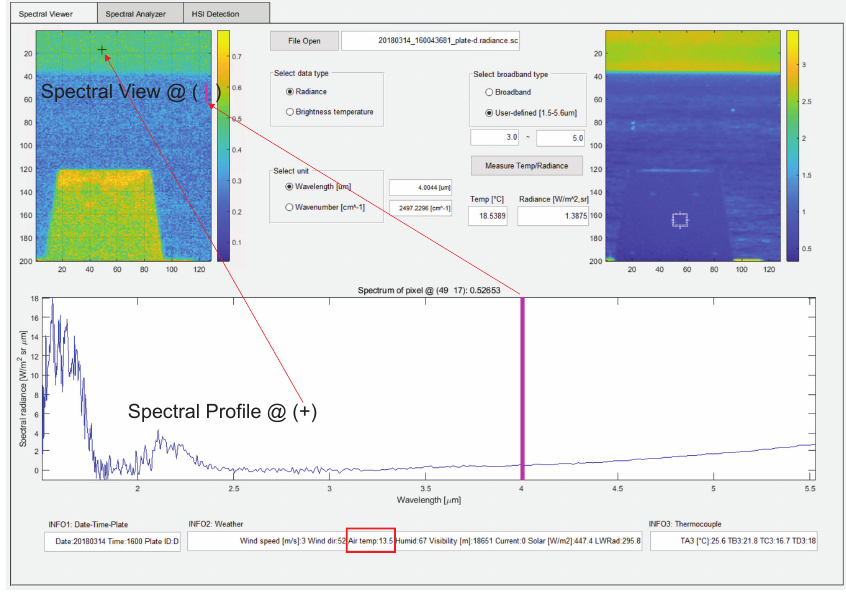
Figure 2. Midwave FTIR image analysis software platform. A spectral image at a selected wavelength can be visualized interactively.